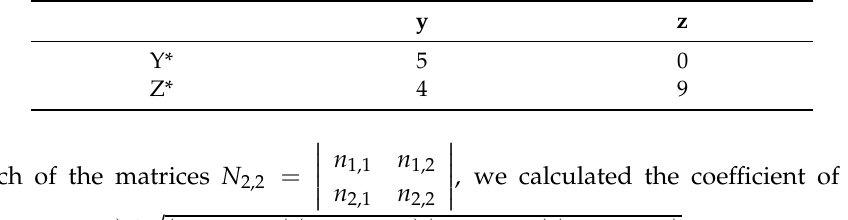
Table 3. The 2 × 2 matrix obtained when comparing the sources “Y” and